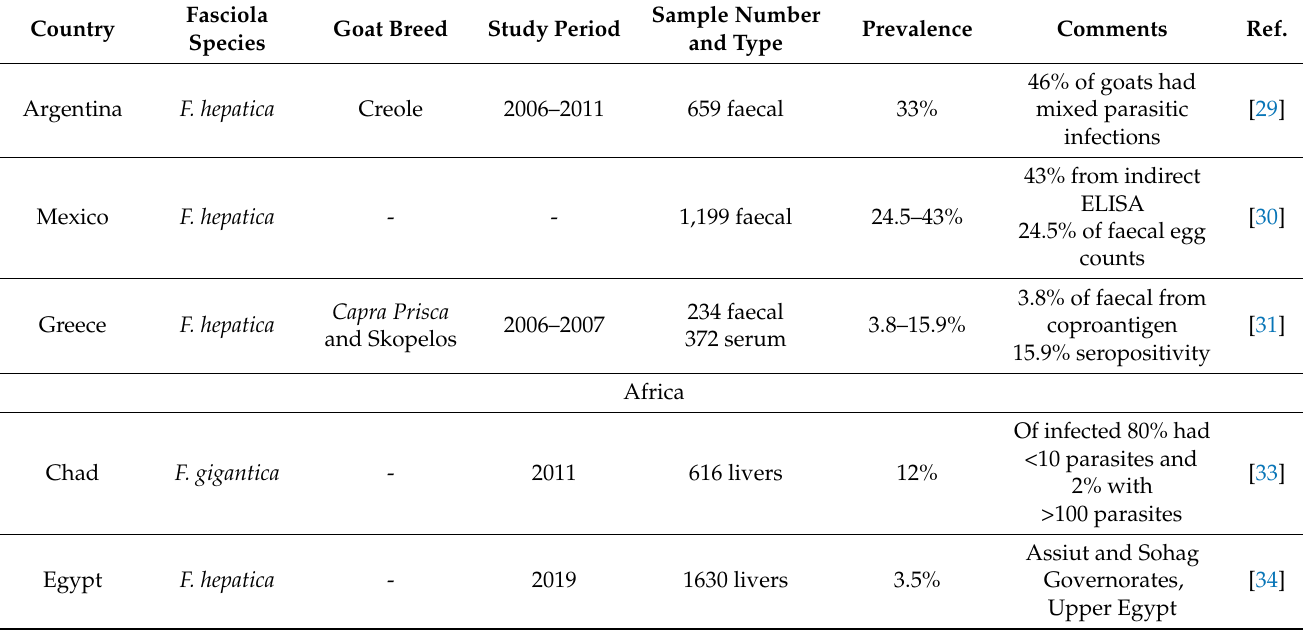
Table 1. Global prevalence of fasciolosis in goats and any associated economic